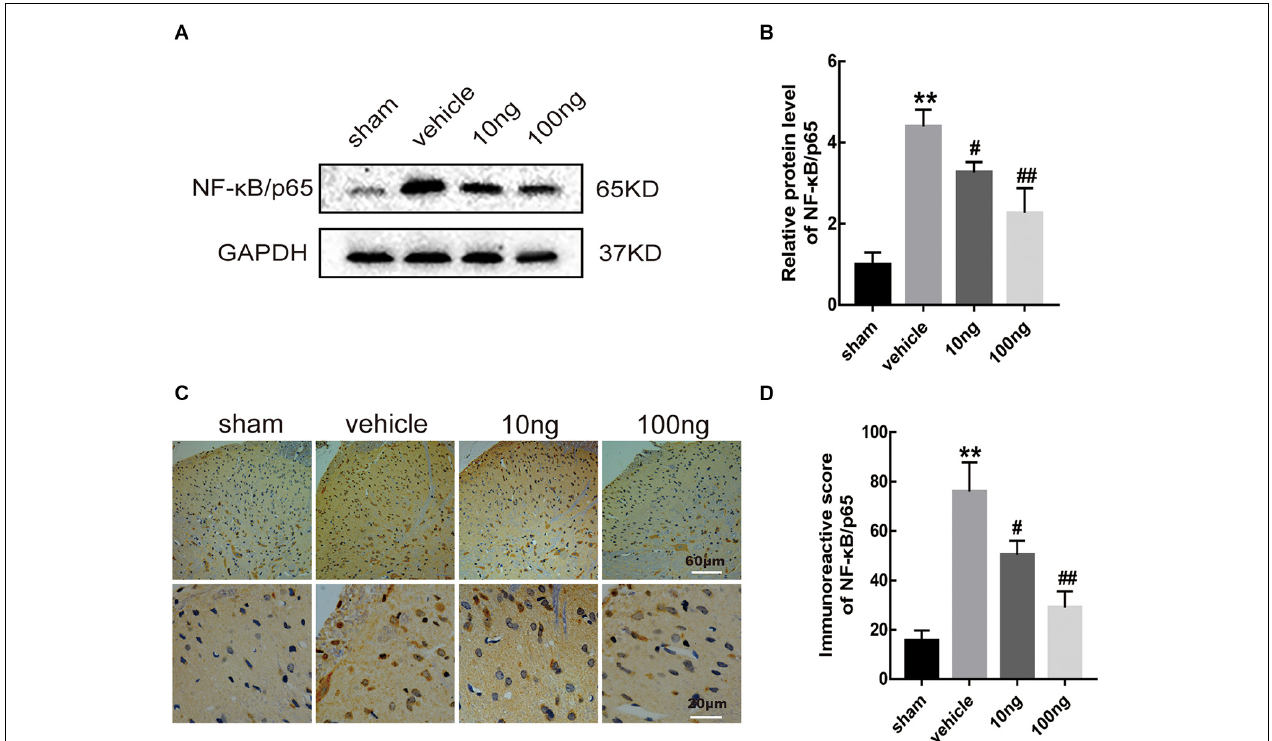
FIGURE 7 | MaR1 reduced levels of protein expression and positive images of NF- κ B/p65 ( n = 6/group). Western blot and immunohistochemistry were used to determine the levels of positive expression of NF- κ B/p65 in spinal dorsal horns. (A,B) MaR1 (10 or 100 ng) reversed the rising protein expression levels of NF- κ B/p65 induced by NCLDH. (C,D) The immunostaining images of NF- κ B/p65 in the spinal dorsal horns were significantly increased in the vehicle group. Intrathecal delivery of MaR1 (10 or 100 ng) decreased the positive expression of NF- κ B/p65. Data are given as the mean ± SD (** P < 0.01 versus the sham group; ## P < 0.01 versus the vehicle group; # P < 0.05 versus the vehicle